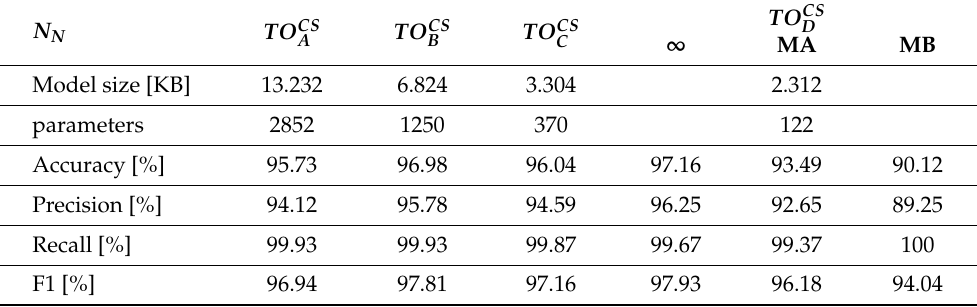
Table 2. Performance metrics of OCCNN models A, B, C, D with temperature input values and CS-processed configurations: Beside the classical classification scores, the overall complexity, in terms of memory consumption, number of parameters and execution time, is enclosed. N